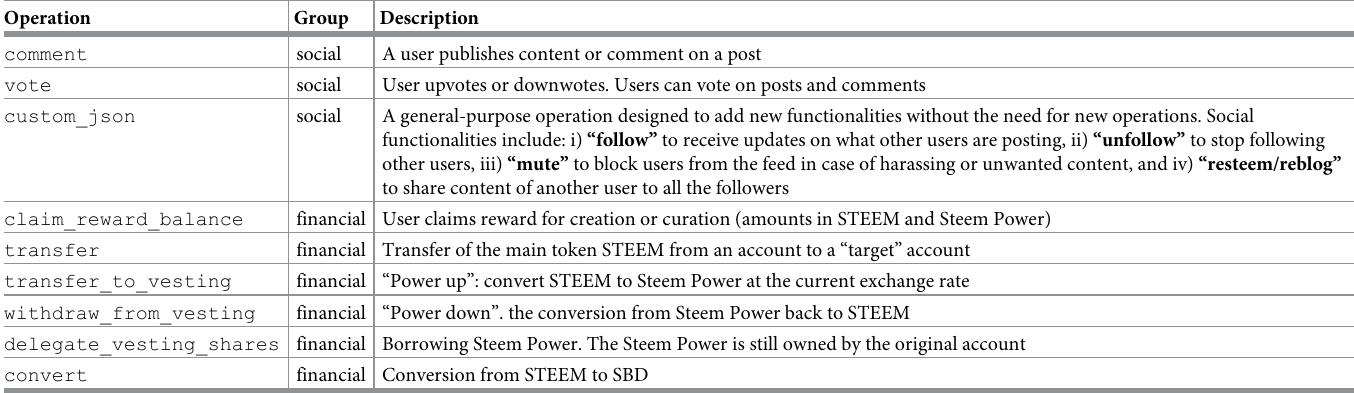
Table 1. List of social and financial operations. Each operation is characterized by its name, its type and a full description.